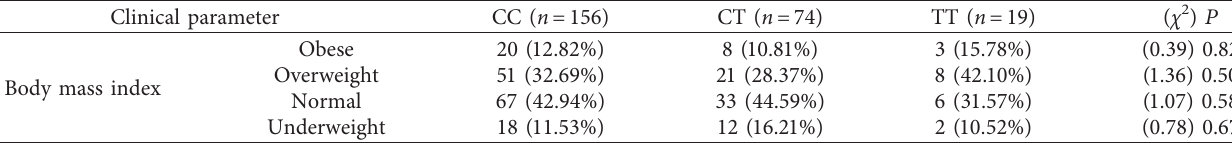
Figure 4: Prevalence of insulin resistance in women with PCOS as depicted by acanthosis nigricans and HOMA values > 2.71 in CC, CT, and TT genotypes of INSR C/T SNP. P value of CC vs. CT vs. TT calculated by Pearson chi-square test. Table 3: Association of INSR C/T SNP (rs1799817) genotypes with body mass index in PCOS.